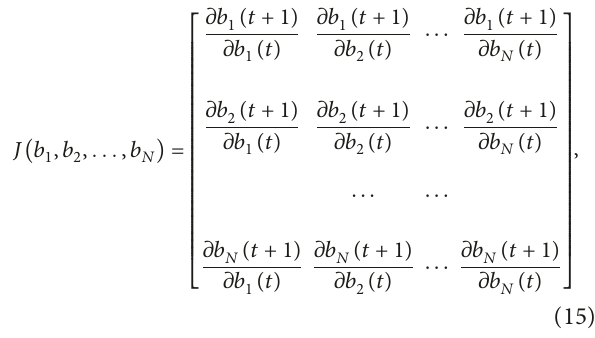
until reaching the maximum value for different spectrum demanding level κ and spectrum utilization η of the V-PU. � κ � 0 . 8, the profit of the V-PU for different φ in the κ 1 2 pricing function is plotted in Figure 5. With increasing number of the parameter φ , the profit of the V-PU from charging higher price is from the V-SU. However, when the price of spectrum resources continues to increase, the V-SU demanding for spectrum resources decreases, and the profit gained by the V-PU also decreases corre- spondingly. The results indicate that there is an optimal value (Ellipse mark) of φ for some V-SUs to maximize the profit of the